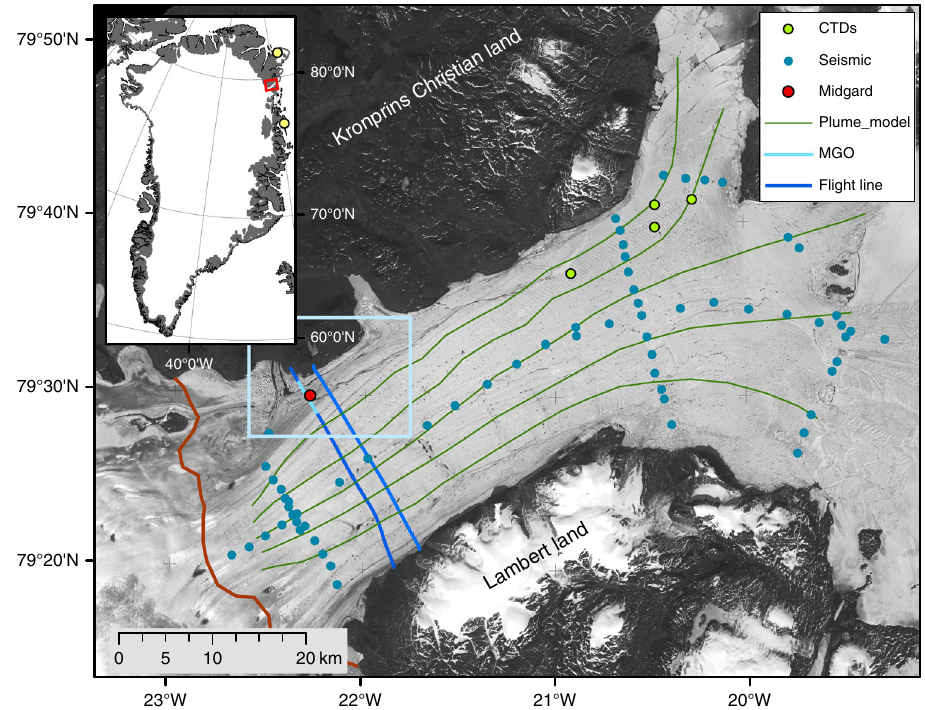
Fig. 1 The fl oating part of 79 North Glacier with the data sets used in the study. 79 North Glacier in Northeast Greenland, with the locations of the cross pro fi les used in this analysis (dark blue: Radar and IceBridge fl ight lines, light blue: MGO cross pro fi le as in Figs. 2,4 and 6). The location of the Midgardsormen experiment is shown as a red dot, while the seismic measurements from 1997 and 1998 are shown as blue dots 13 . The light green dots represent the CTD pro fi les used in this study. The green lines represent transects used for the plume model simulations. The light blue box shows the geographical extent of Fig. 4 and the upstream part of the MGO-ridge (gray winding feature). The grounding line is indicated by the red line in the lower left corner. The ice shelf front is located to the right of the image and towards the North (Djimphna Sund, at the upper right part of the image). The background image is taken from a Landsat 5 scene from 25 July 1998. The locations of the weather stations in Danmarkshavn and Station Nord are shown in the inset map as yellow